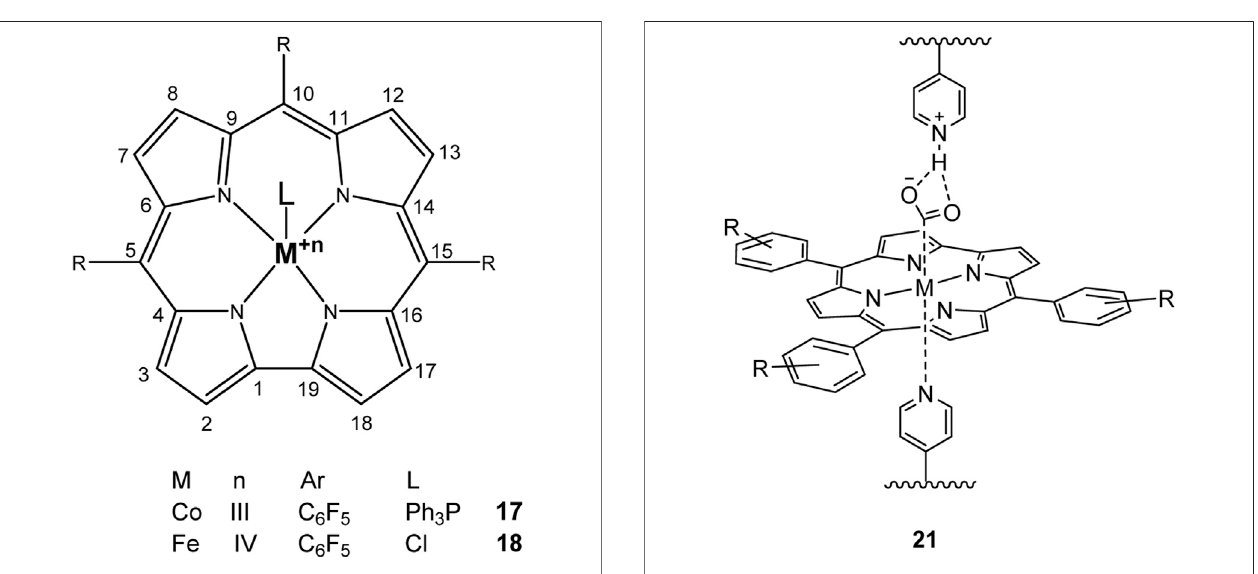
FIGURE 6 | Co and Fe corroles for the homogeneous CO 2 reduction to CO and H 2 in MeCN solutions.